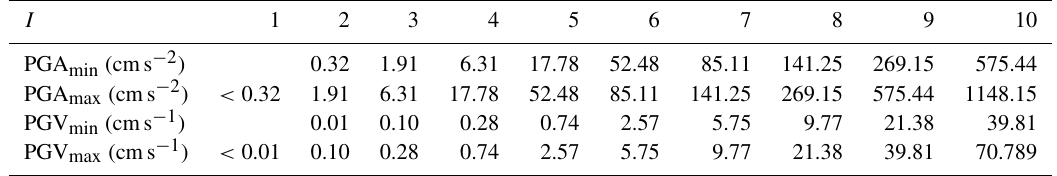
Table 3. Table of PGA and PGV value intervals for the calculation of I ; values are taken from Cataldi et al. (2021).